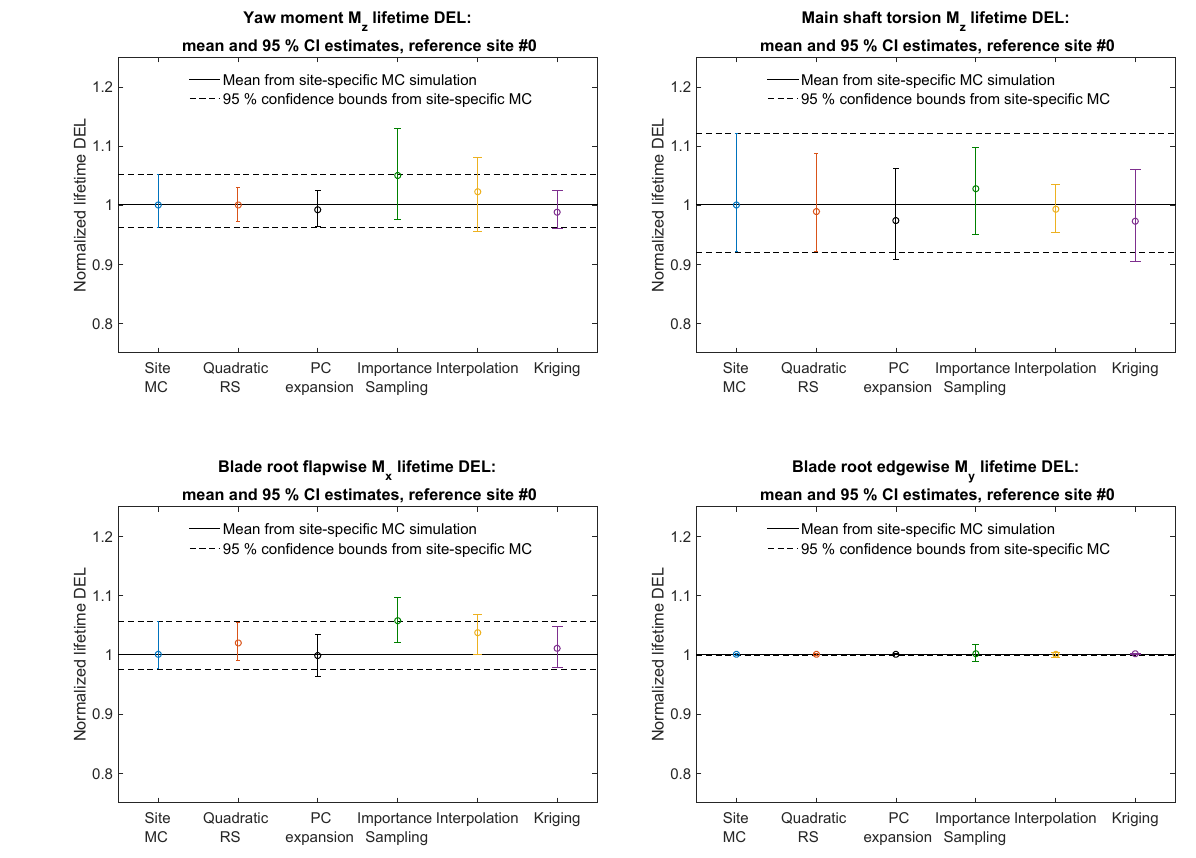
Figure 9. Comparison of predictions of the lifetime damage-equivalent loads (DELs) for six different estimation approaches. All values are normalized with respect to the mean estimate from a site-specific Monte Carlo